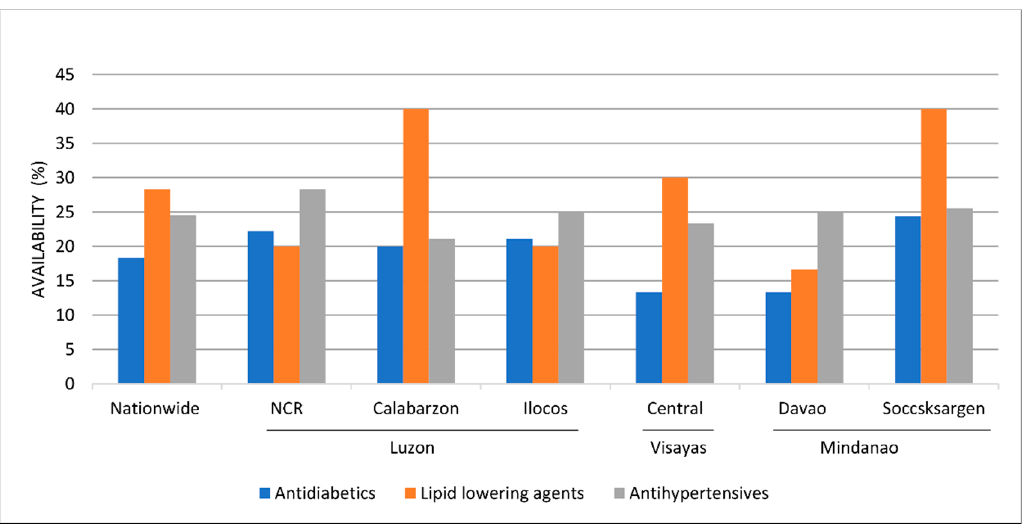
Figure 1. Availability of LPGs in the public sector per pharmacological category, nationwide and across regions. NCR, National Capital Region.